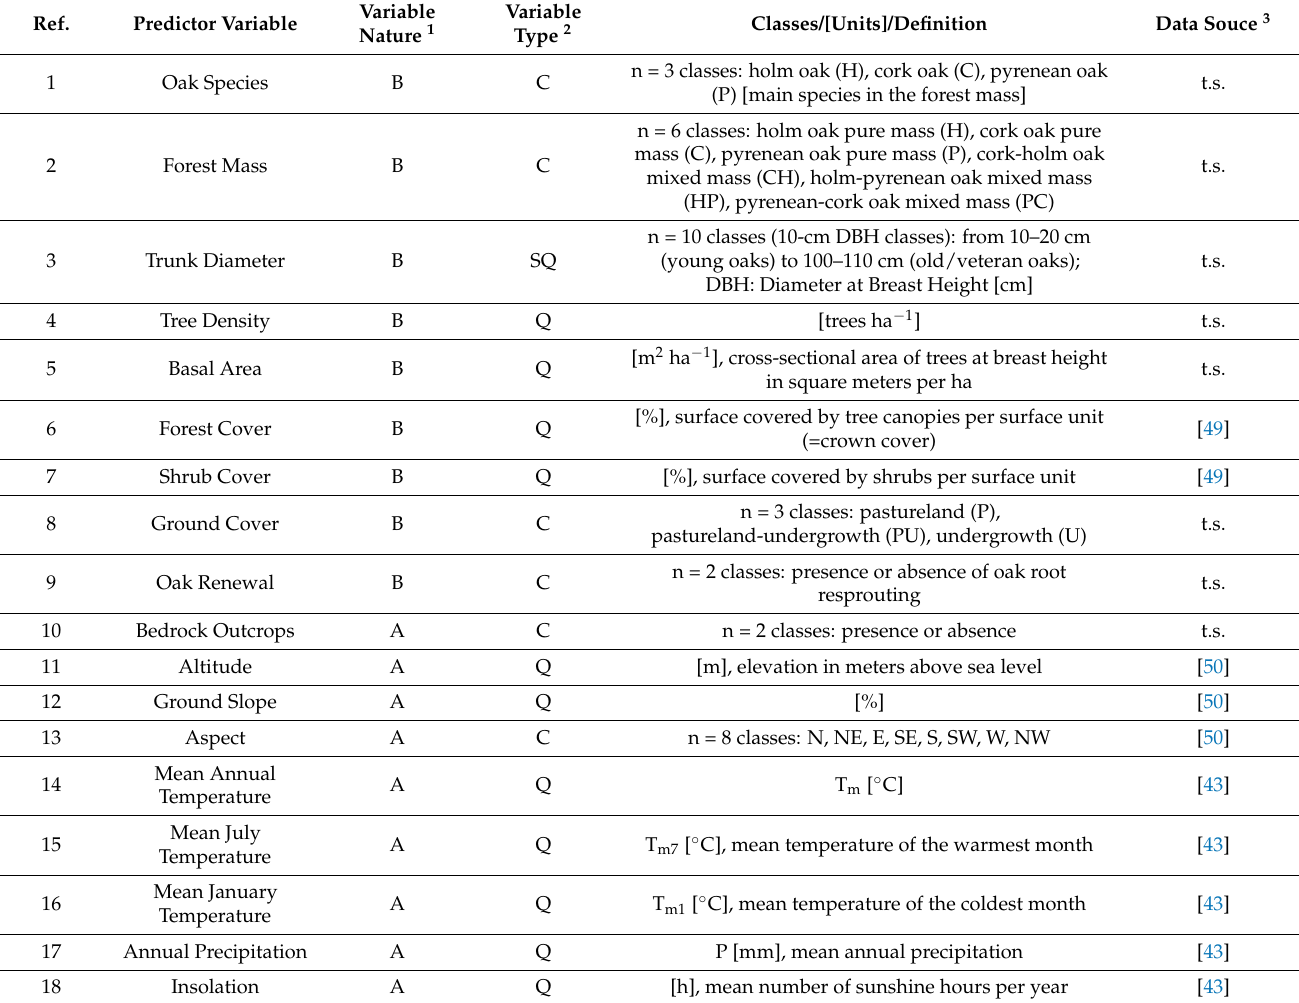
Table 1. Categorical or quantitative predictor variables measured or estimated in each oak stand. Variables were scored for subsequent GLMMs as either biotic or abiotic according to their forest, dendrometric, physiographic, geological, or climatic features.